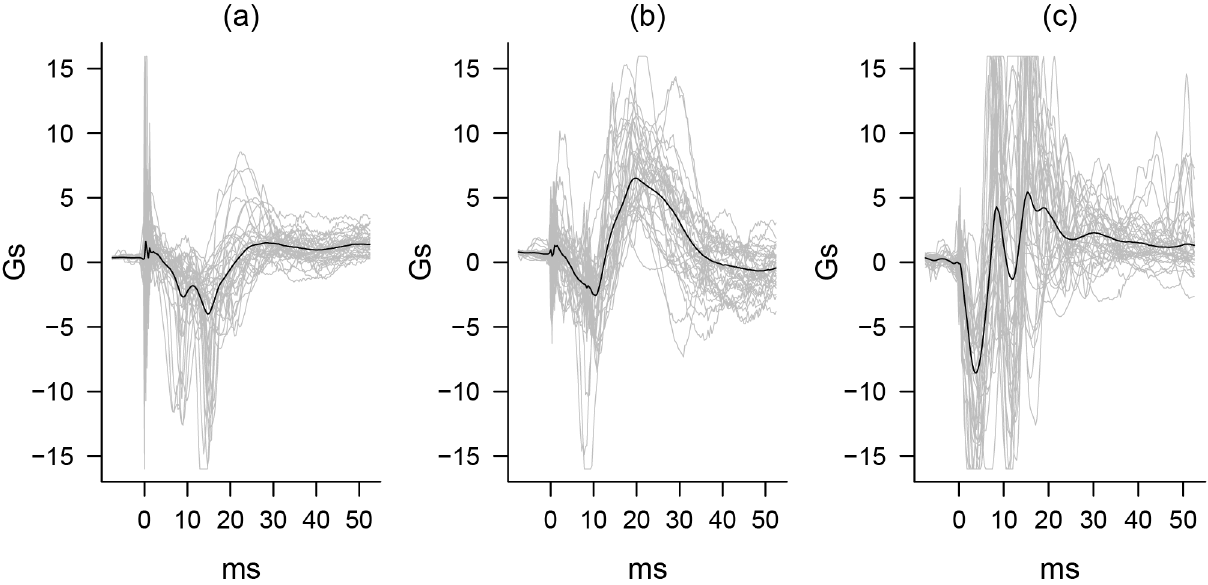
Figure 3. Gunshot Features with Averages. Individual and averaged gunshot acceleration readings along the (a) X-axis, (b) Y-axis, and (c) Z-axis. Individual gunshot acceleration readings (in grey) are a 10 percent sample of the 359 gunshot acceleration readings (in black) in the sample average.